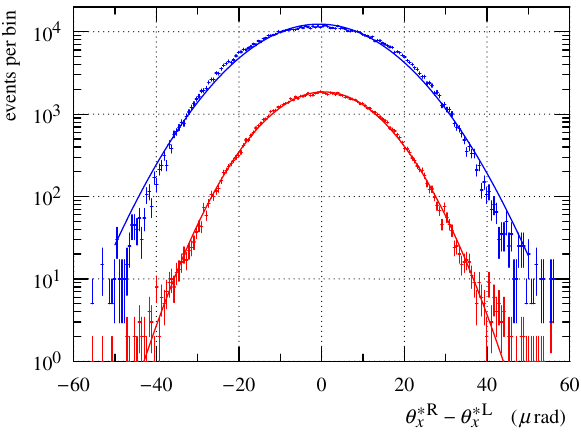
Fig. 3 Difference between horizontal scattering angles reconstructed in the right and left arm, for the diagonal 45 bottom - 56 top. Red: data from the beginning of fill 5317, blue: data from the fill end (vertically scaled 5 × ). The solid lines represent Gaussian fits